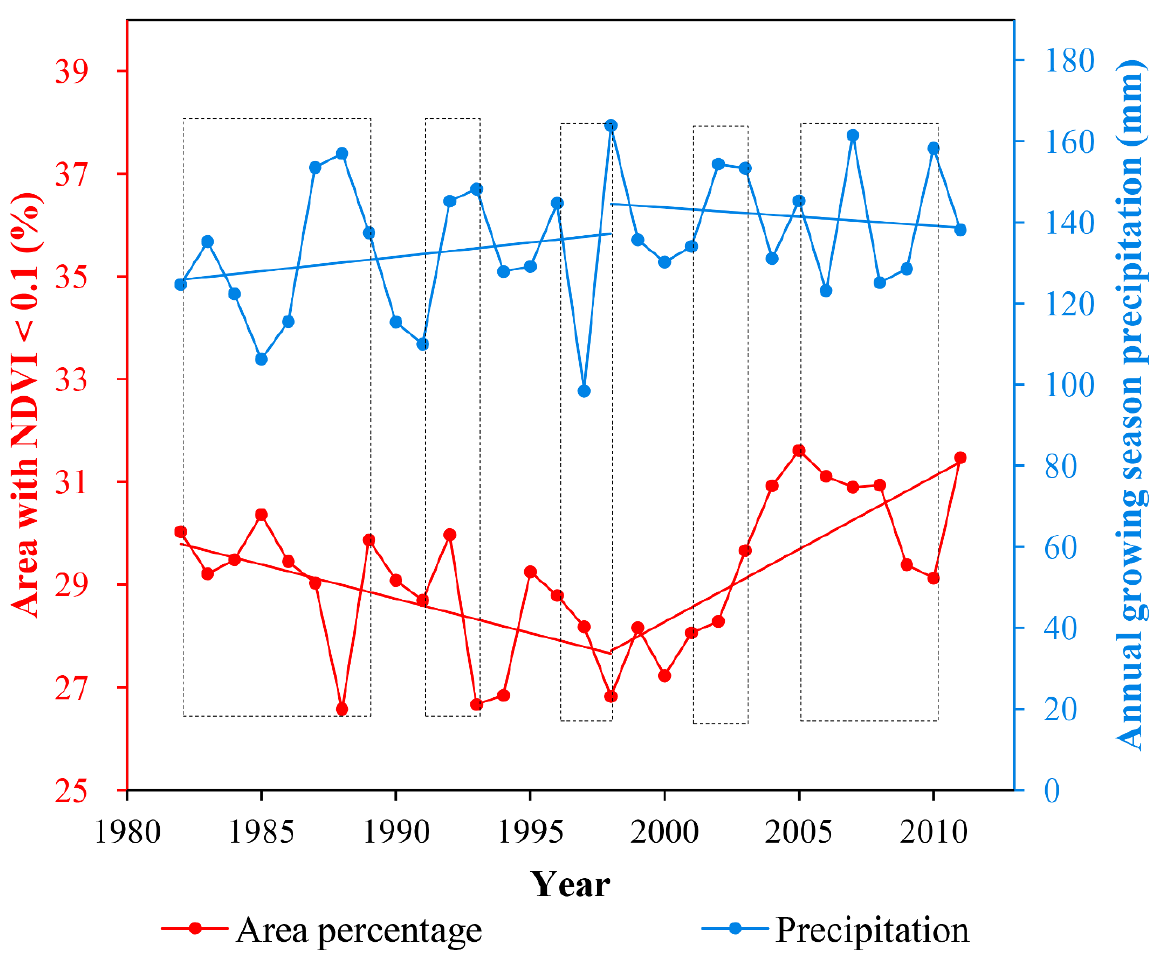
Figure 3. Annual variations in bare and sparsely vegetated areas (red line) and annual precipitation in the western study region (blue line) from 1982 to 2011. Boxes indicate reverse trends of precipitation and area